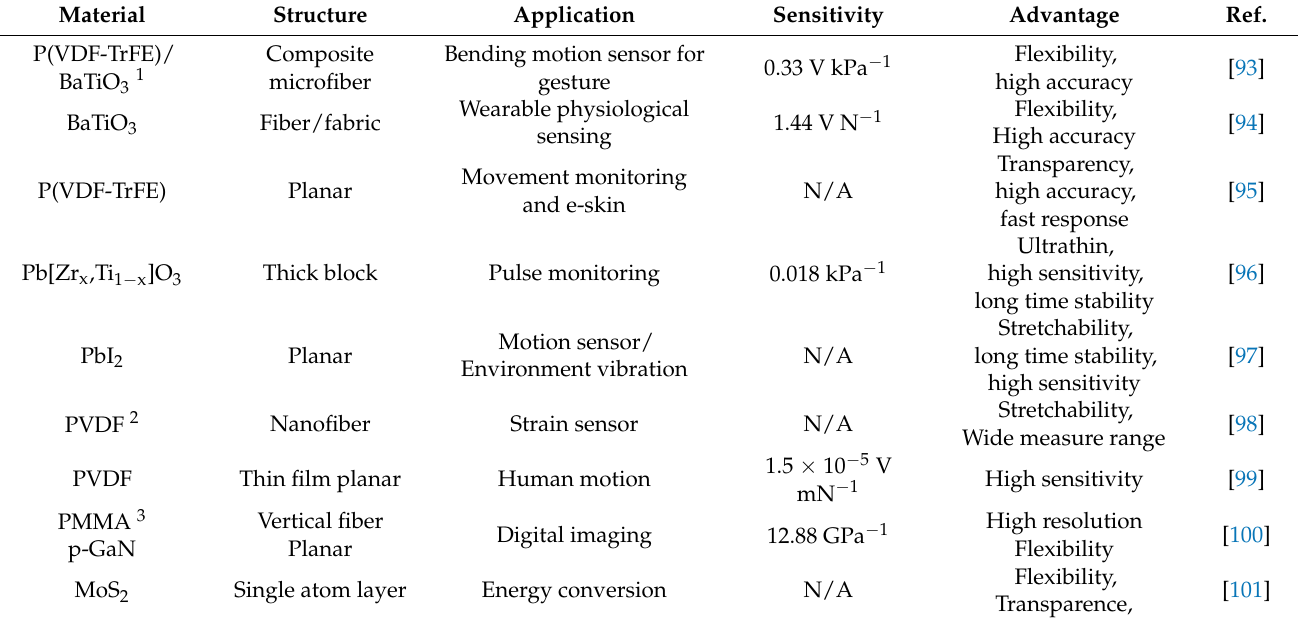
Table 3. Comparative sensing performances of the piezoelectric-based